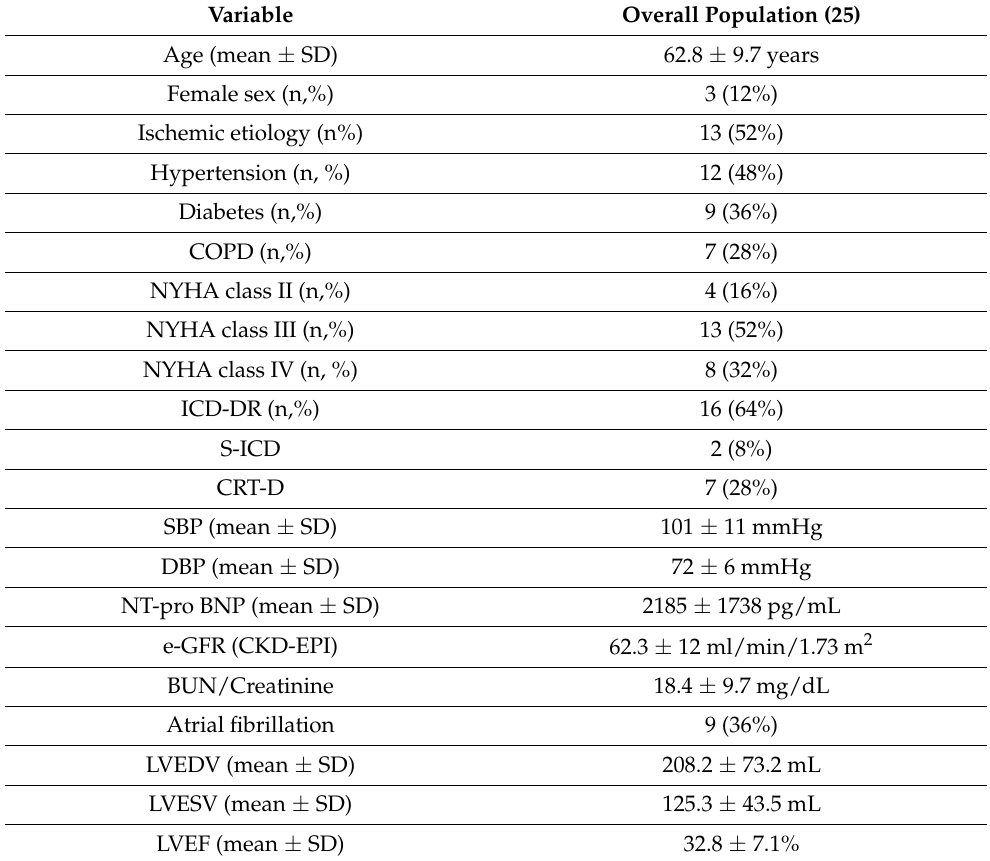
Table 1. Clinical and echocardiographic patients’ characteristics at